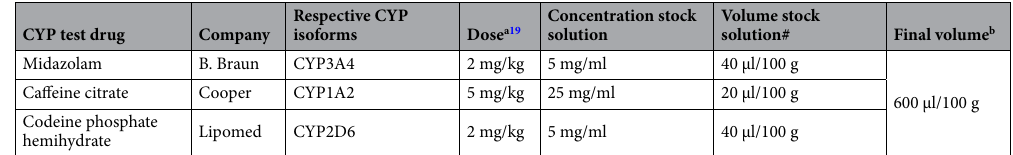
Table 1. Drug concentration, dose, and source. ( a dose per body weight; #needed volume of stock solution (µl)/100 g mouse diluted in a final volume of 200 µl; b final volume of diluted drug cocktail per body